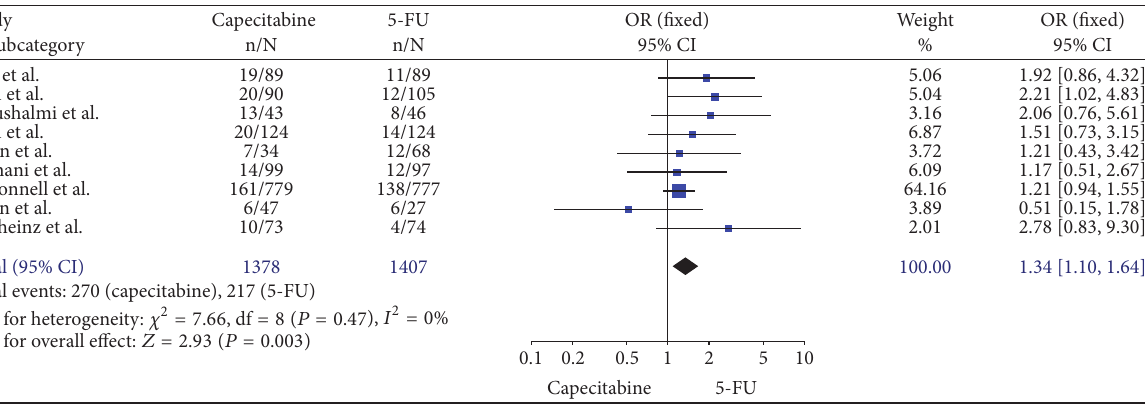
Figure 2: Forest plot of odds ratio (OR) for pCR rate of all trials.